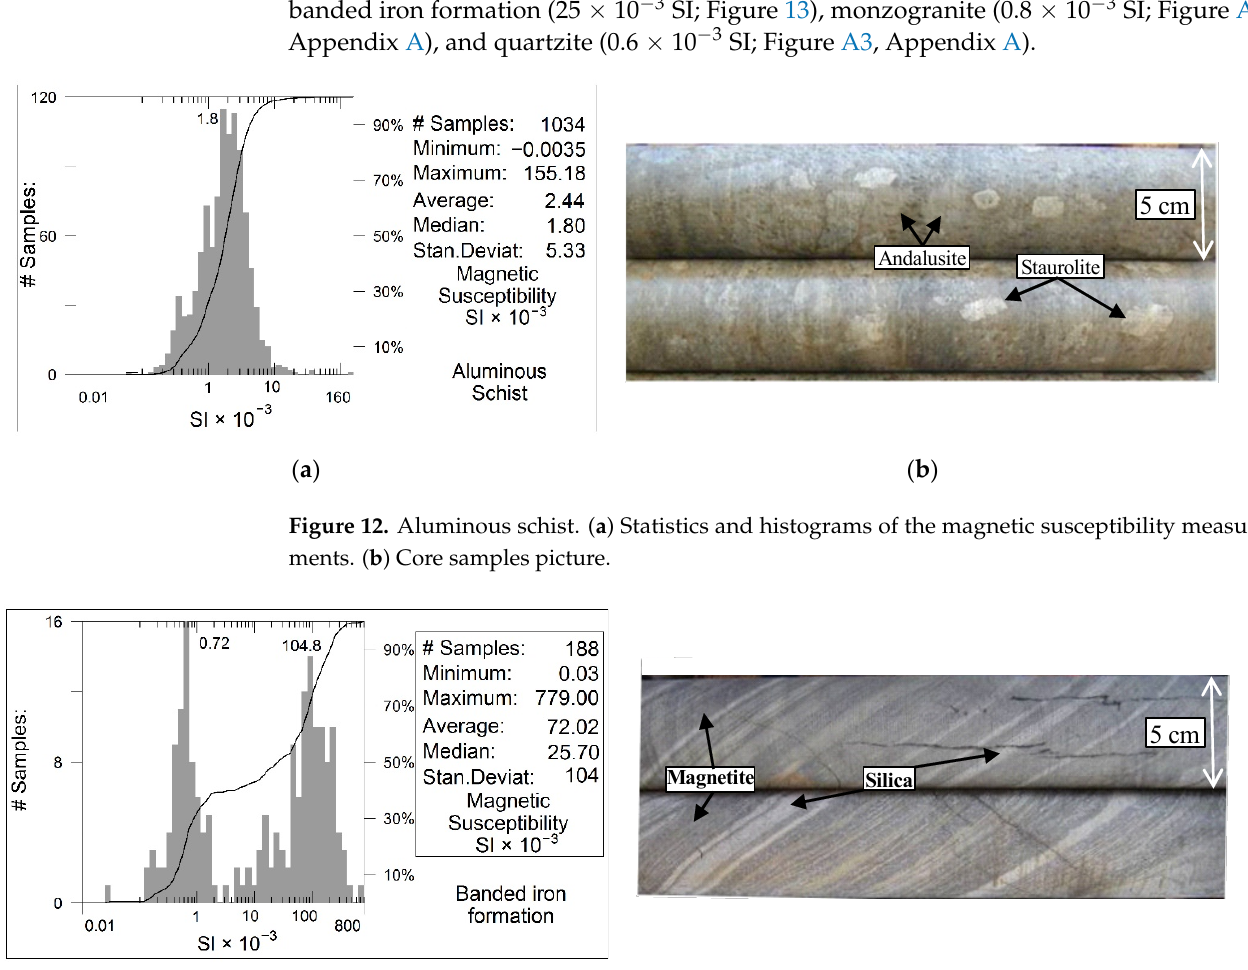
Figure 13. Banded iron formation. ( a ) Statistics and histogram of the magnetic susceptibility measurements. ( b ) Core samples picture.